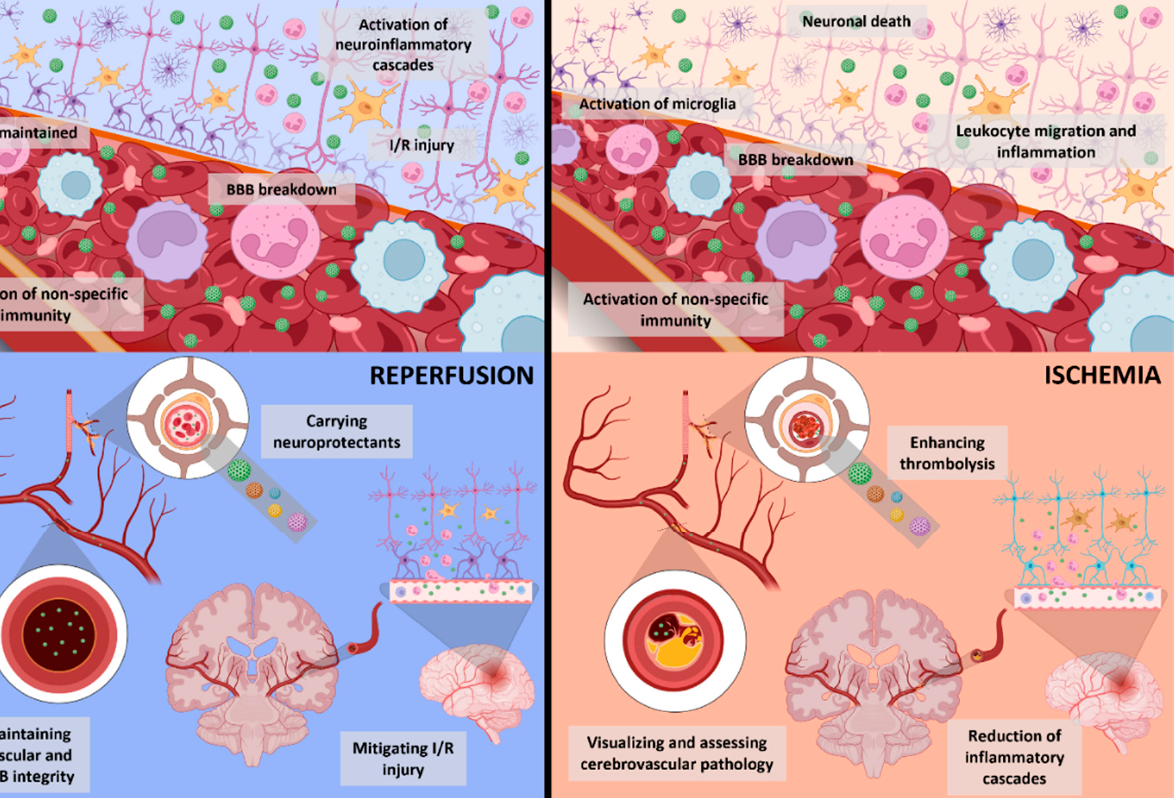
Figure 3. Schematic depicting acute changes with reperfusion following successful vessel recanalization (on the left ) contrasted with ischemia following vessel occlusion (on the right ). Despite vessel recanalization, there may still be disruption in the function or structure of BBB or ischemic changes, compounded by neuroinflammatory cascades triggered by reperfusion or direct effects of thrombolytics. Nanoparticles and nanoconjugates (green dots) may help target detrimental pathophysiological changes in reperfusion and ischemia by delivery of neuroprotective and vasoprotective agents to minimize vessel injury, or by ameliorating ischemia-triggered cascades, and neuroinflammation. Theragnostics hold the potential to improve diagnostic and prognostic tools and bolster current acute treatments. BBB—blood-brain barrier, I/R—ischemia/reperfusion.